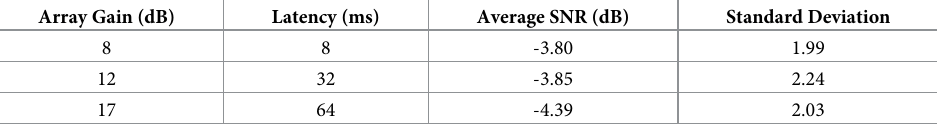
Table 1. Experimental conditions and threshold results. Three gain / latency combinations from the RT60 = 0.6s beamforming simulation from Fig 2 used in this experiment. The average thresholds (SNR of enhanced signal to noise) and standard deviation across subjects for each of the 3 conditions. (dB = decibels; ms =